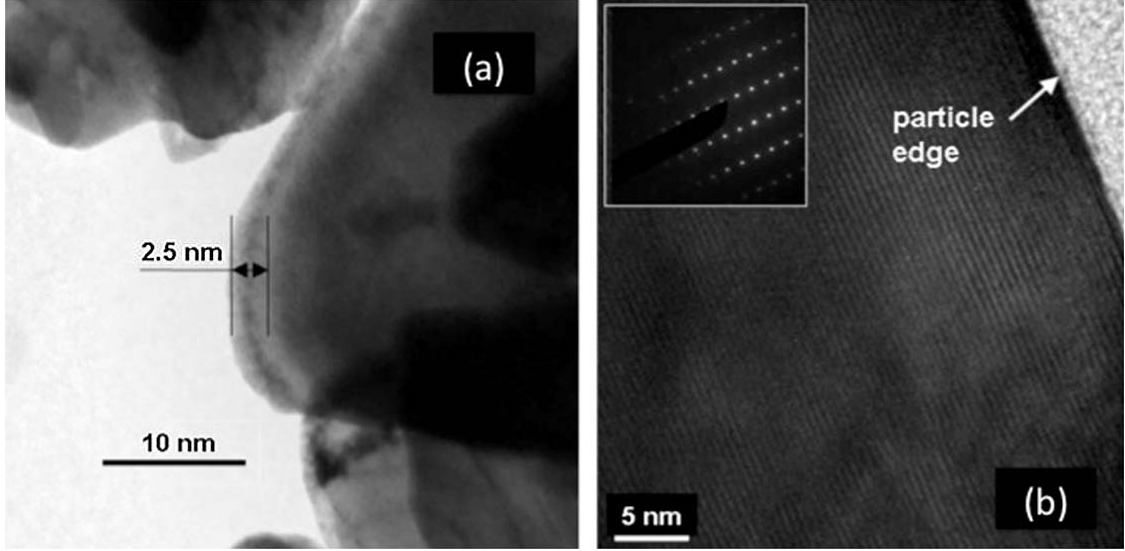
Figure 1. High resolution transmission electron microscopy (HRTEM) features of LiNi Mn Co O (LNMC) powders for as-grown ( a ) and heat treated sample with 1/3 1/3 1/3 2 sucrose at 600 °C for 30 min in air ( b ). (Reprinted with permission from [57]. Copyright 2011